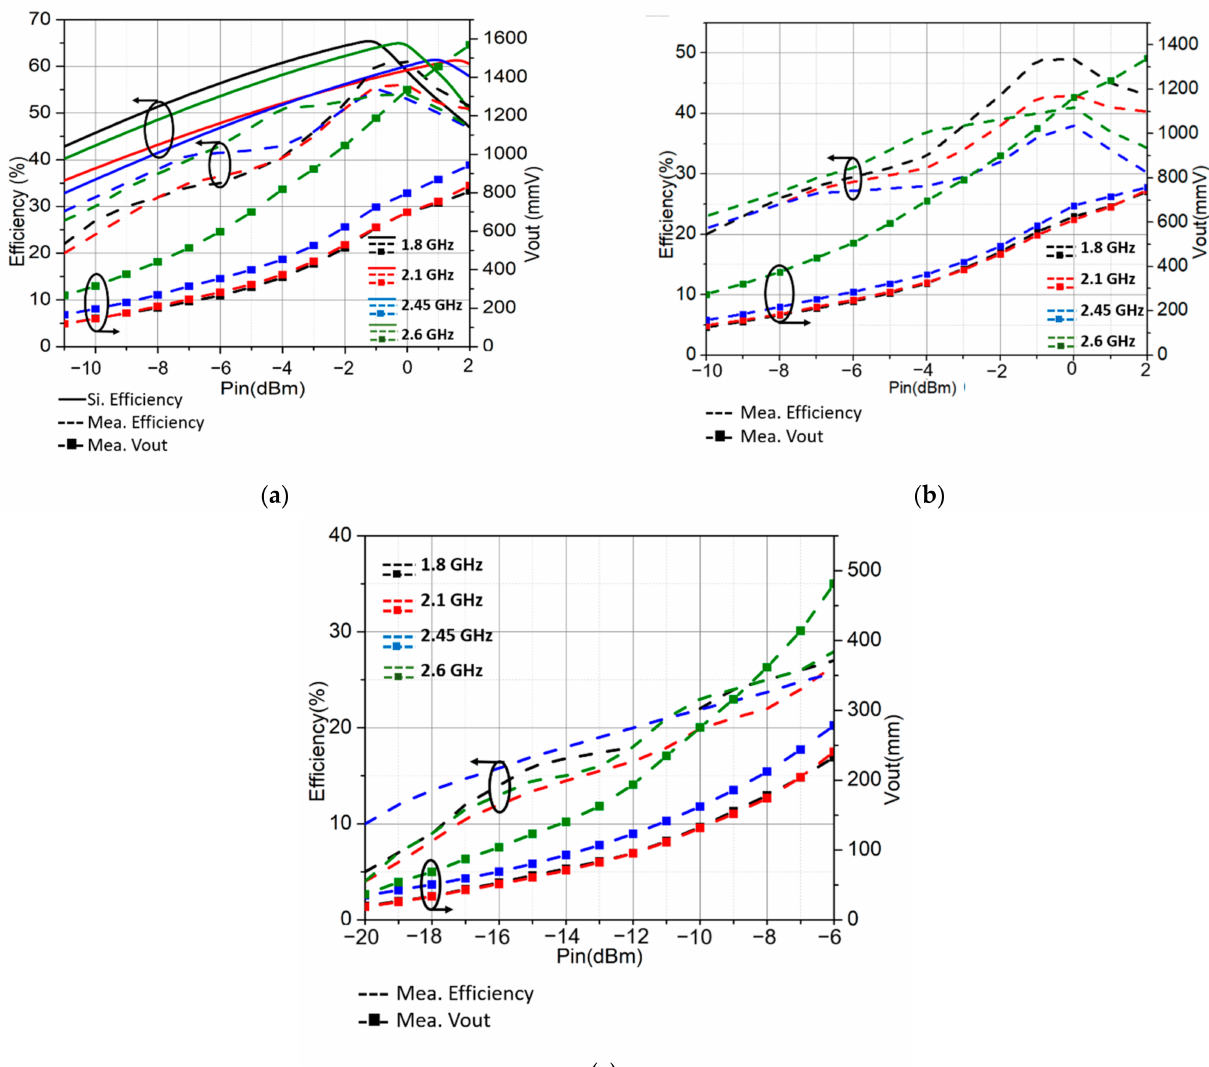
Figure 13. ( a ) Simulated and measured AC–DC efficiency of the rectifiers; ( b ) measured AC–DC efficiency of the quadplexer and rectifiers; ( c ) measured RF–DC